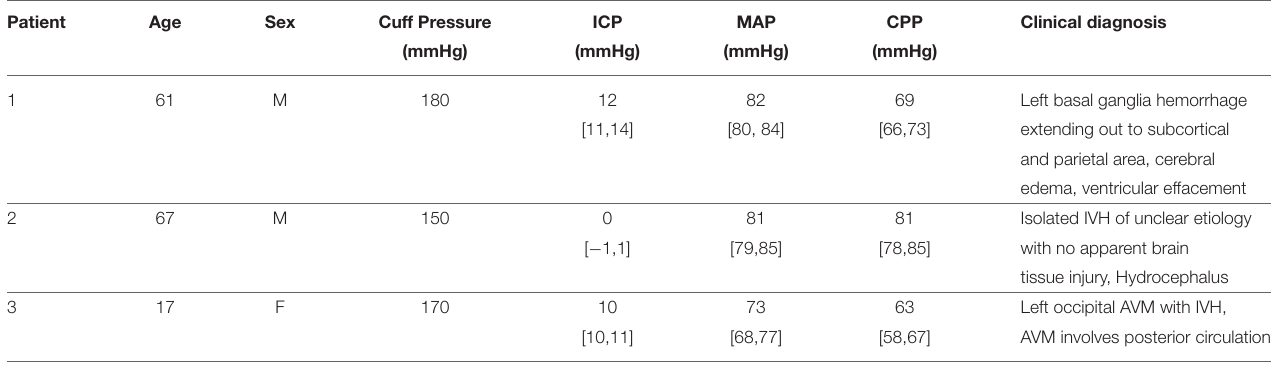
TABLE 1 | Summary of patient information from neurocritical care unit.